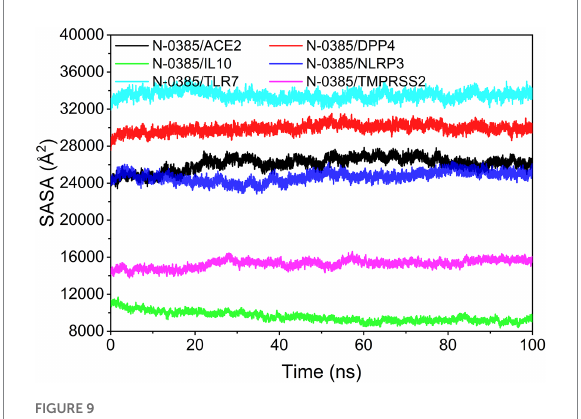
FIGURE 9 Analysis of solvent accessible surface area